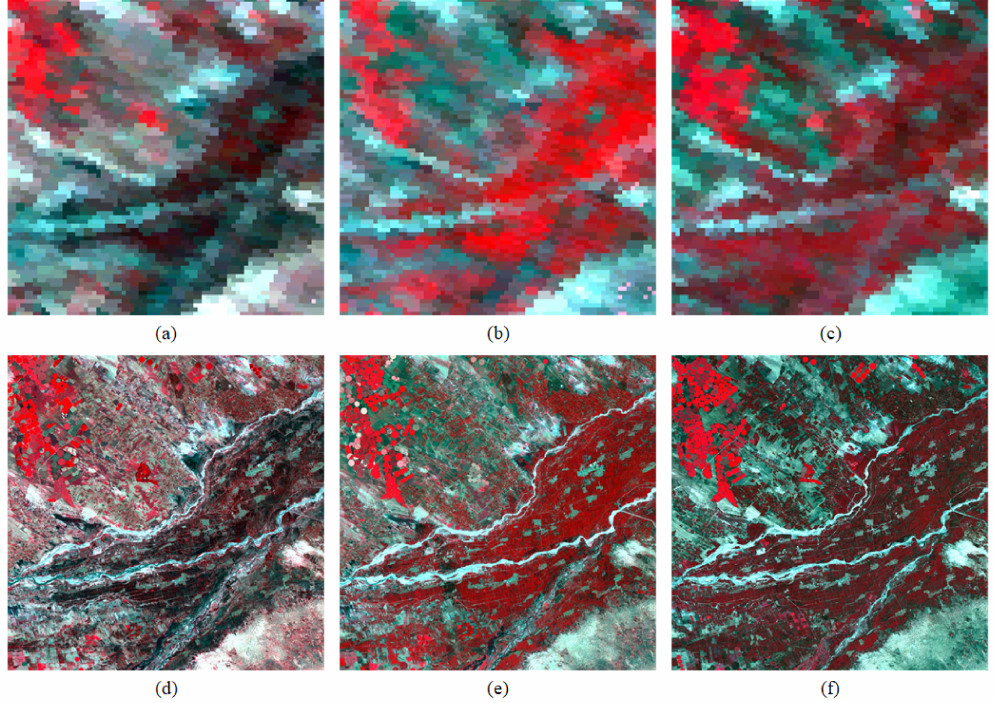
Figure 6. Composite MODIS (top row) and Landsat (bottom row) image pairs on 21 June ( a , d ), 7 July ( b , e ), and 25 September ( c , f ) 2015 from the AHB [32,33] dataset. The AHB dataset mainly contains significant phenological changes of the